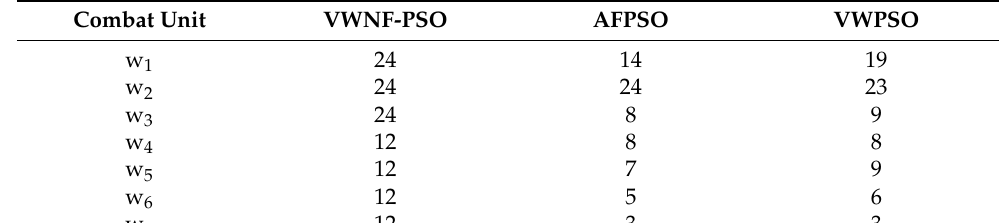
Table 12. Interceptor consumption.